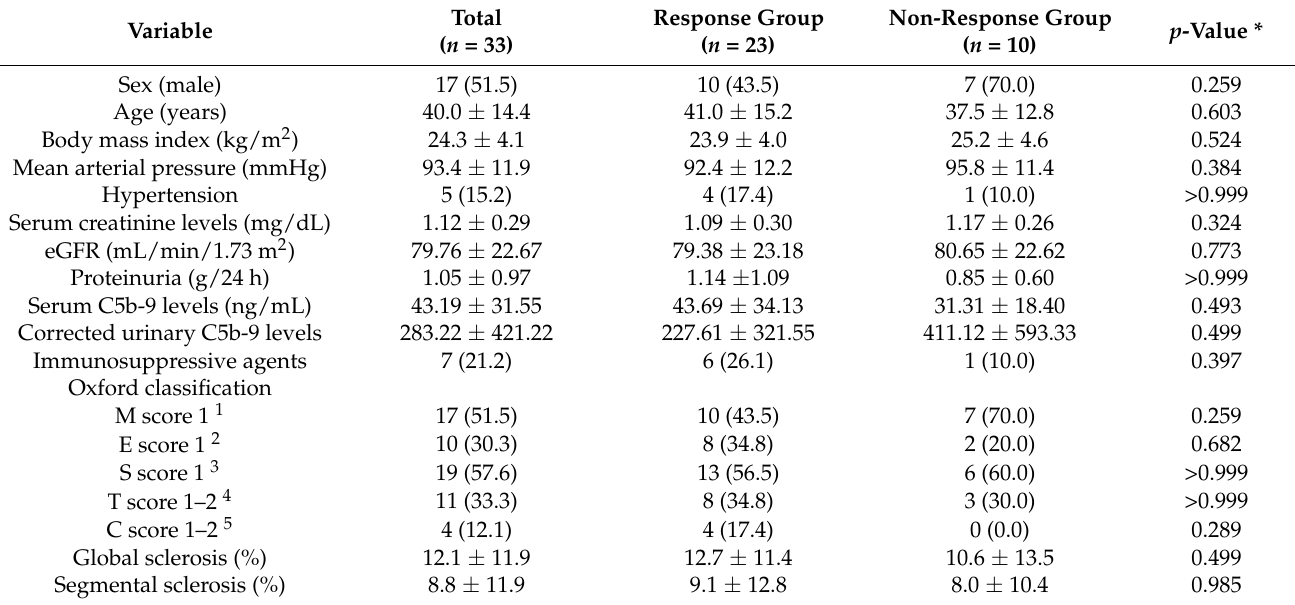
Table 1. Baseline characteristics of enrolled patients.